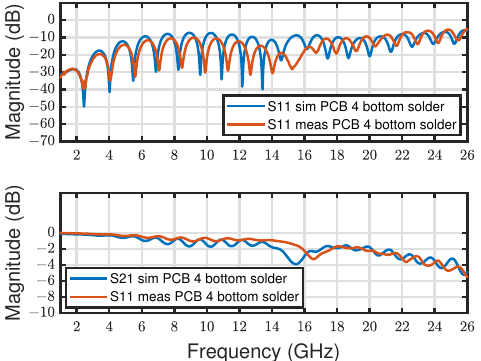
Figure 6. Comparison of insertion and transmission losses of PCB 4 applying solder to connect the bottom ground metal with the SMA connector body (compare Figure